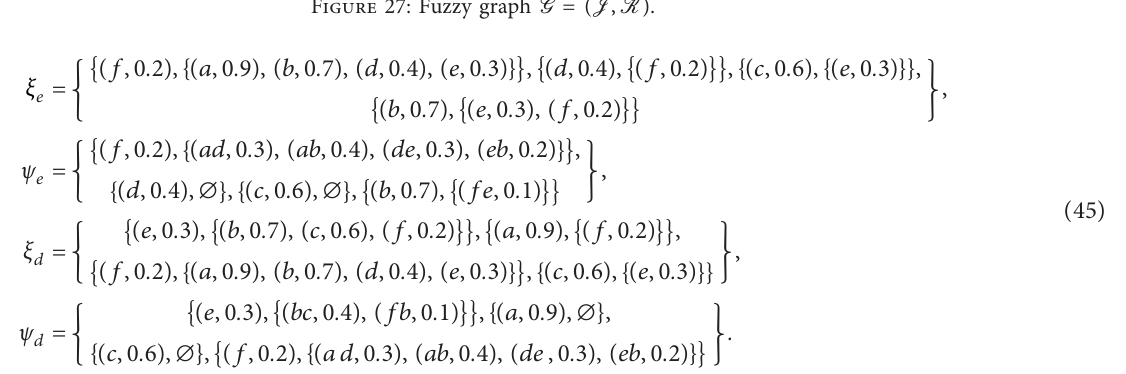
Figure 27: Fuzzy graph G � ( J , K ) .